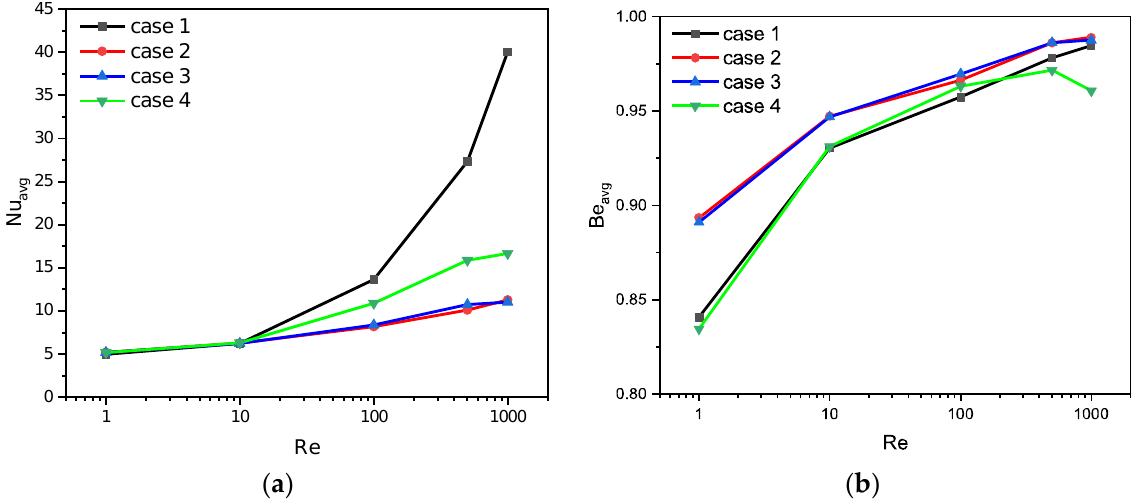
Figure 8. Effects of the movement directions of the upper wall parts (Cases 1, 2, 3 and 4) on the ( a ) average Nusselt number Nu avg and ( b ) average Bejan number Be avg at Ha = 0 and 𝑆𝑡𝑒 = 0.2.